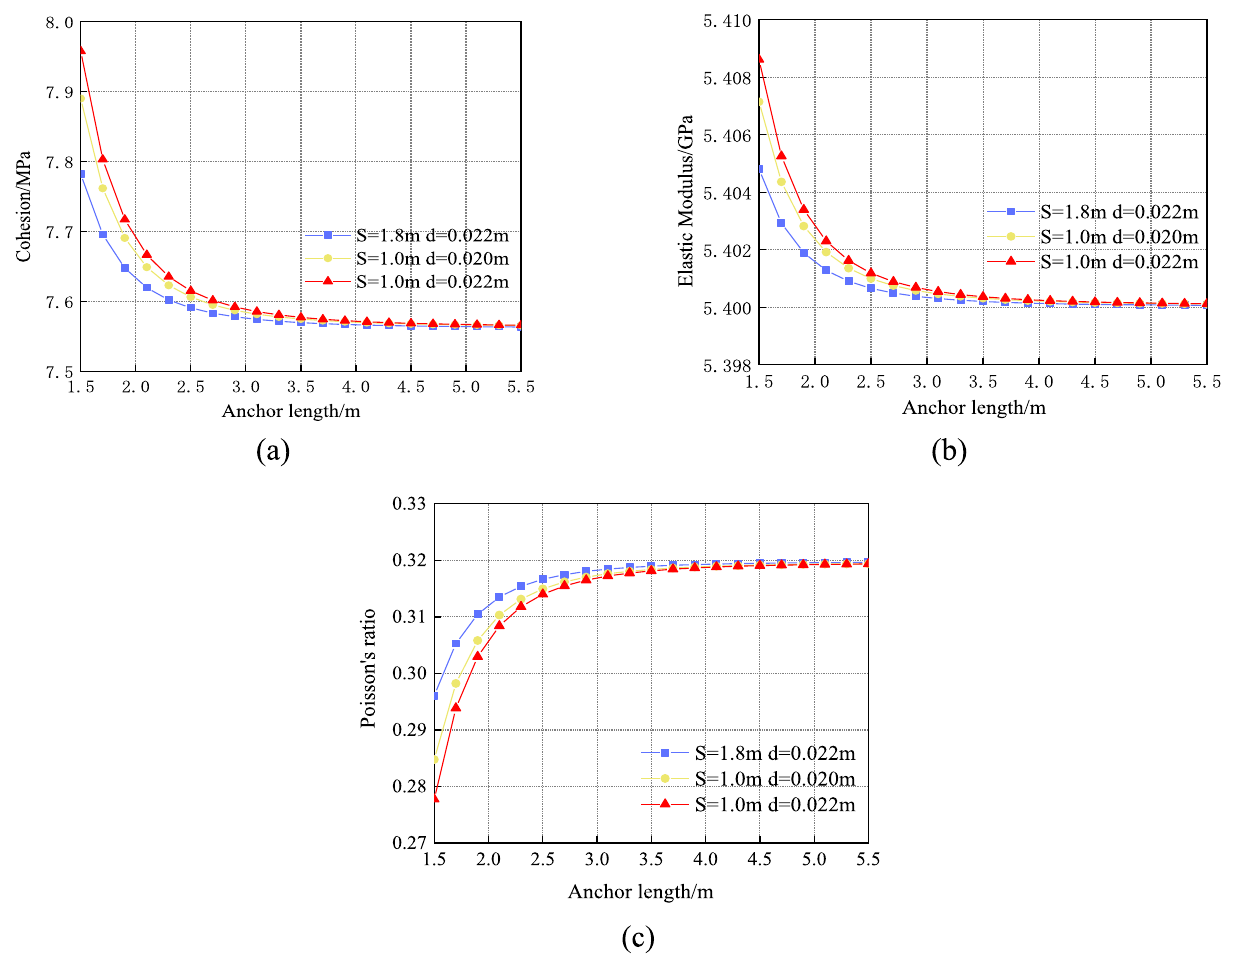
Figure 12. Influence of anchor length, spacing, and diameter on physical and mechanical parameters of surrounding rock reinforcement body: ( a )Influence on cohesion; ( b ) Influence on elastic modulus; ( c ) Influence on Poisson’s